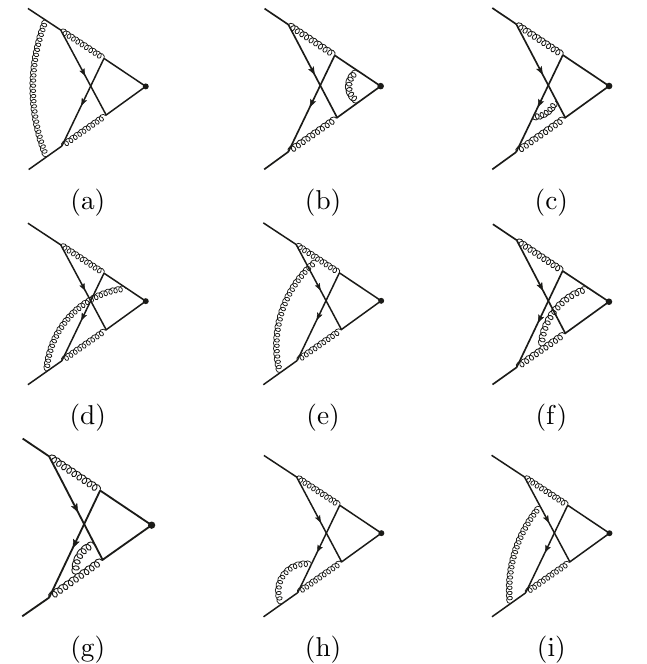
in the double- 1